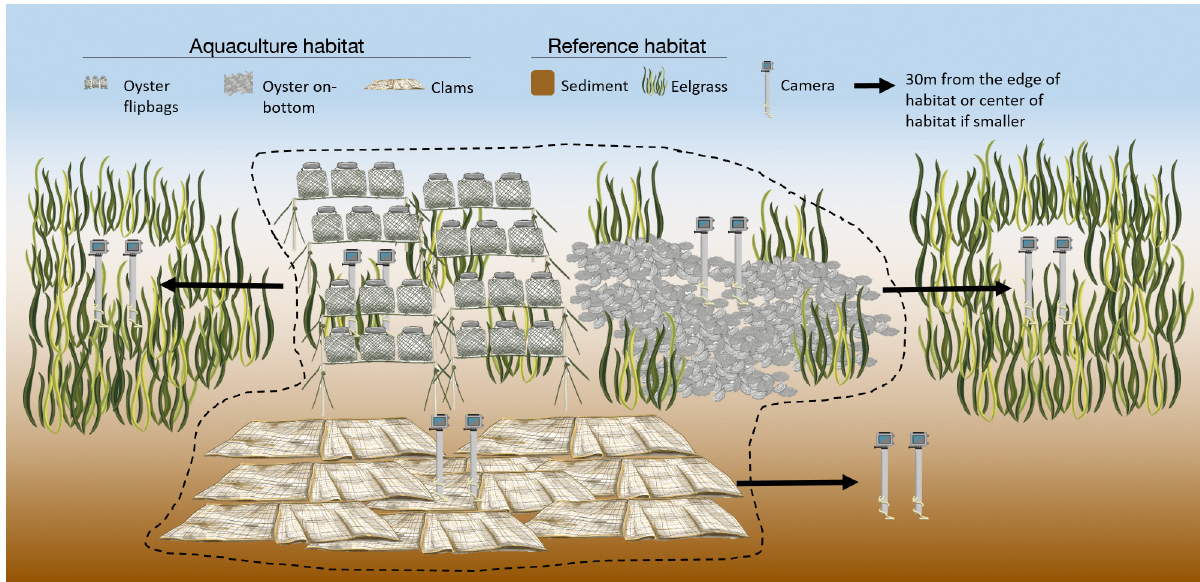
Fig. 2. Camera locations in aquaculture (oyster flipbag, oyster on-bottom, clam) and reference (sediment, eelgrass) mesohab- itats for a given aquaculture farm (dashed line) during a single sampling event. Two cameras were set in each mesohabitat for every sampling event. Reference sites were 30 m away from the edge of aquaculture habitat but at similar depth and other environmental conditions. On certain farms, the same site served as a reference for multiple aquaculture sites if available reference areas were limited and the habitats were similar. Drawings by Frances